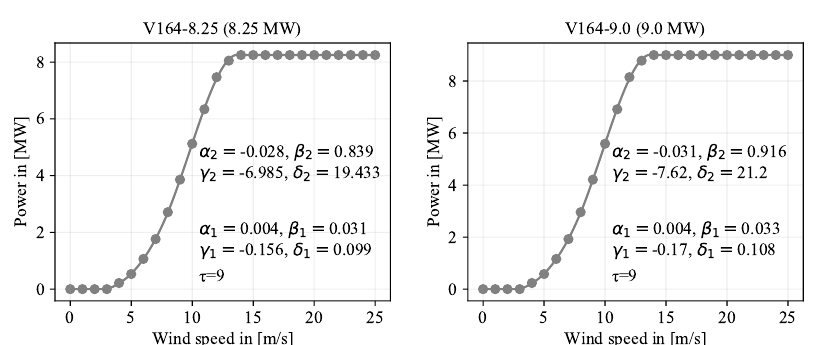
( k ) Power curve of wind turbine V164-8.25 (estimated from V164-9.5). Figure A6. Cont